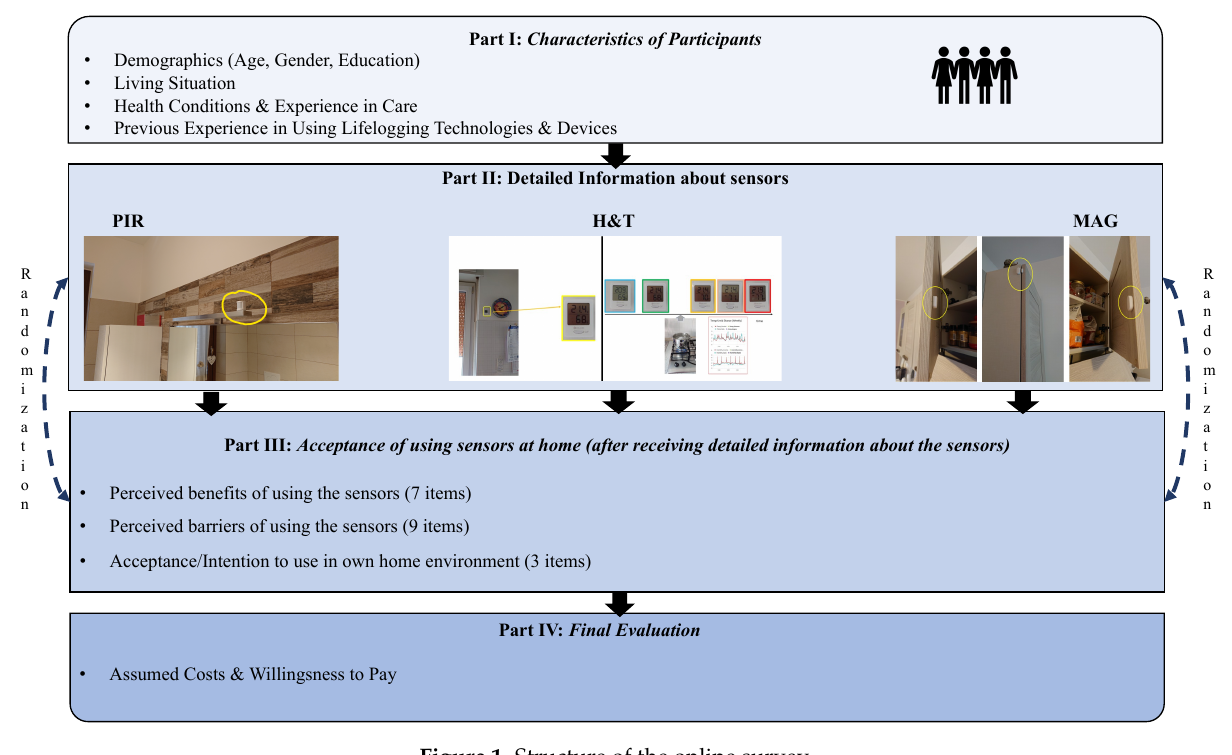
Figure 1. Structure of the online survey.